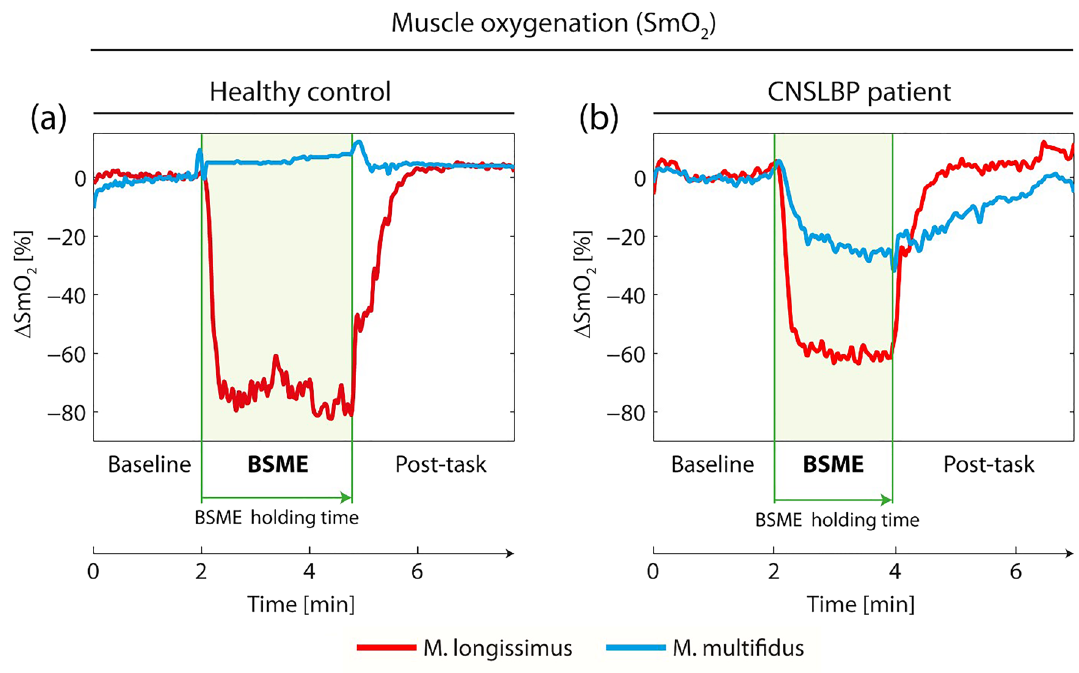
Figure 2. Muscle oxygenation of M. longissimus and M. multifidus of a representative asymptomatic subject ( a ) and a representative CNSLBP patient ( b ) before (0–2 min), during (2 to maximal 6 min) and after execution of the Biering–Sorensen muscle endurance (BSME) test. The green lines indicate the start and the end of the BSME